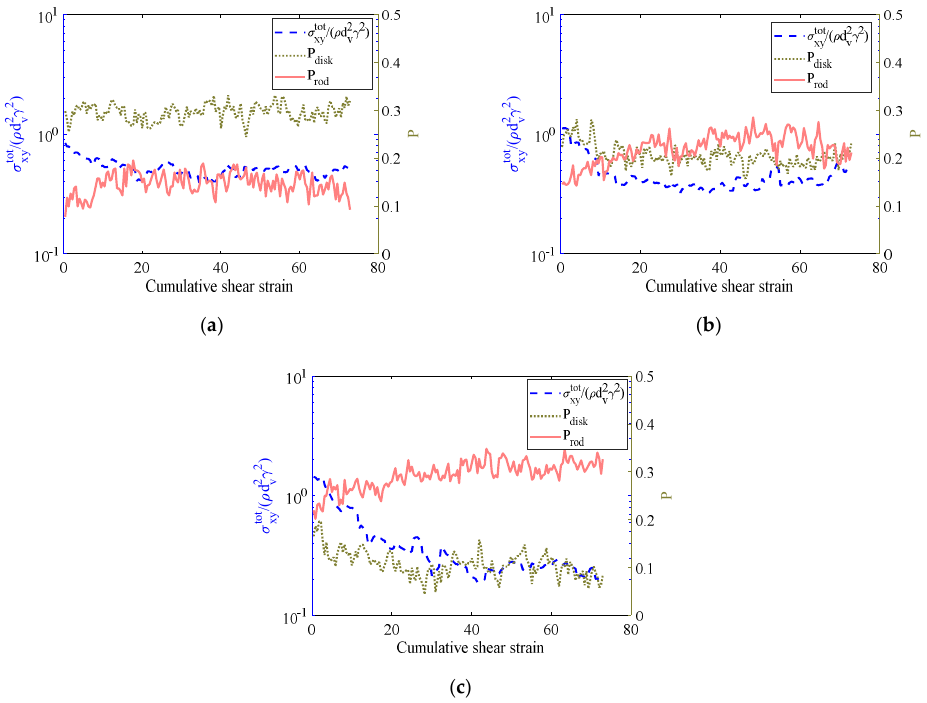
Figure 8. Evolution of normalized shear stress and fraction of stacking particles P with cumulative shear strain for binary mixture flows of AR = 0.3 (disks) and AR = 6 (rods) with ( a ) C = 0.25, ( b ) C = 0.5, and ( c ) C = 0.75. The solid volume fraction is ν =